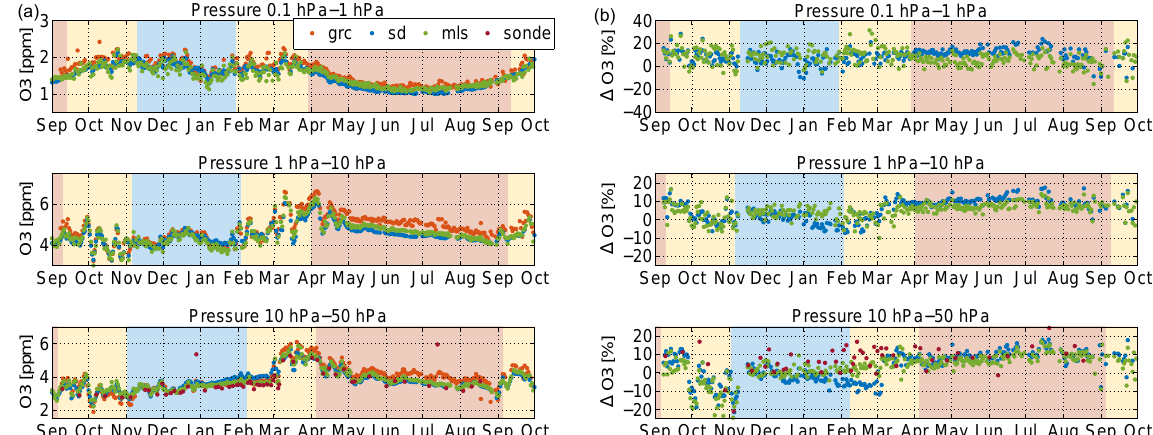
Figure 5. Daily mean of GROMOS-C and MLS measurements and SD-WACCM simulations averaged over three pressure intervals (a) . In the lowest pressure interval, individual measurements from the balloon-borne ozone sonde are also displayed. All profiles are convolved with the averaging kernels of GROMOS-C. Relative difference between GROMOS-C measurements and the remaining data sets. (b) The period of polar night is indicated by the blue background and the period of polar day by the red background. The yellow background indicates the period between polar day and night with daily sunrise and sunset.